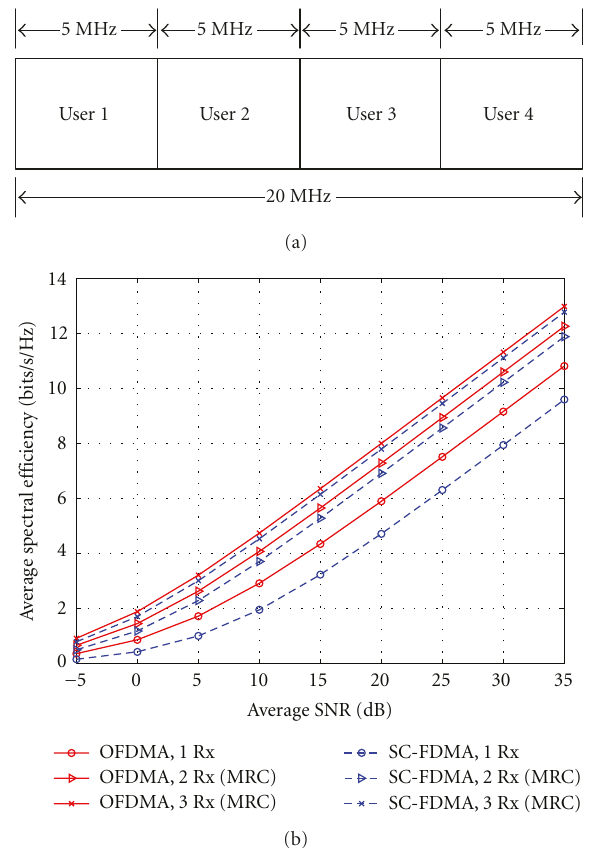
Figure 6: Comparison of the achievable information rate between OFDMA and SC-FDMA for di ff erent numbers of receive antennas in SCME “urban-macro” scenario. The system consists of 4 users with each occupying 5MHz bandwidth.